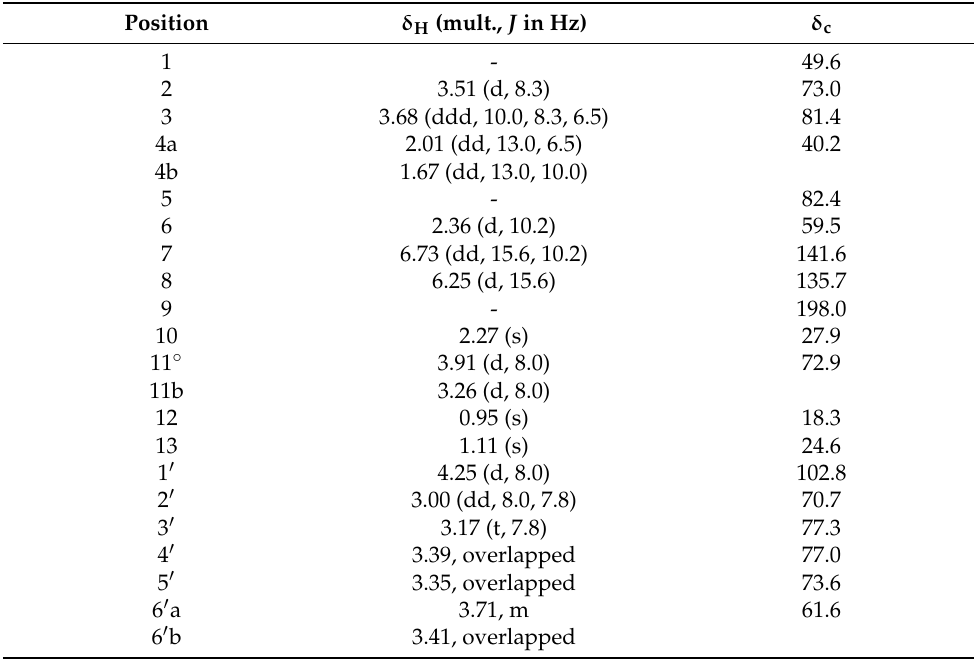
Table 1. 1 H- and 13 C NMR data for euphocactoside ( 5 ) in DMSO- d 6 . Position δ H (mult., J in